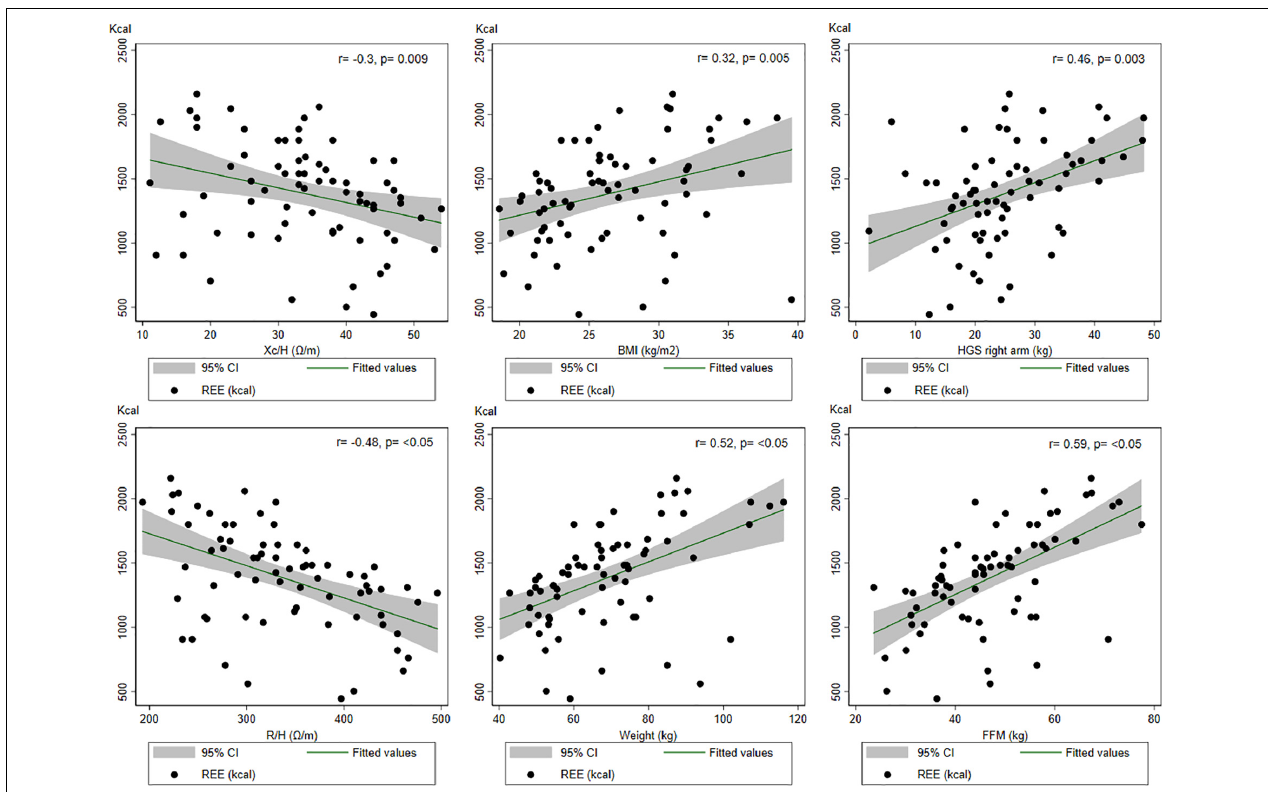
FIGURE 1 | Correlations between some variables of interest and the indirect calorimetry